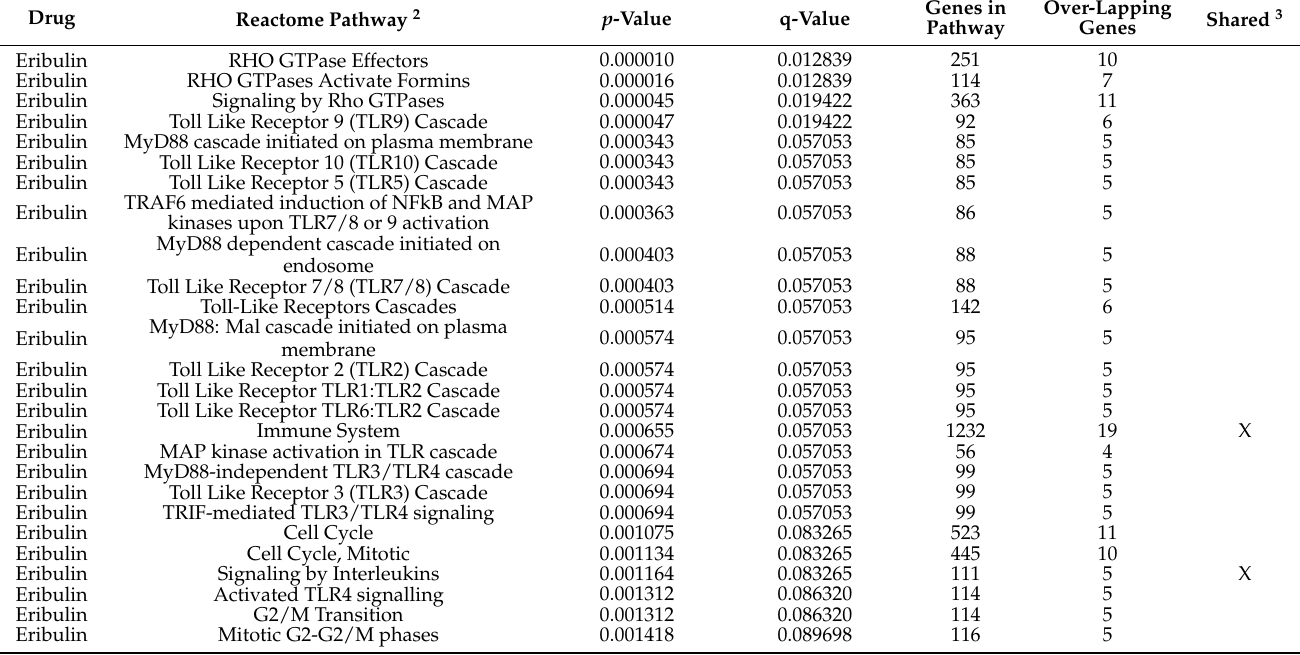
Figure 4. Network propagation and Reactome pathway analyses. ( A , B ) Network propagation from query sets consisting of the 9 eribulin UFGs ( A ) and the 13 vinorelbine UFGs ( B ) yielded the 100- gene networks shown, which included 7 of the 9 eribulin UFGs and all 13 of the vinorelbine UFGs; 2 eribulin UFGs, C5ORF38 and GPR157 , were not themselves captured in the network propagation. Purple-highlighted network nodes represent original UFG query input genes. ( C – J ) Reactome pathways derived from the 100-gene query sets obtained from network propagation. Full Reactome maps are shown for eribulin ( C ) and vinorelbine ( D ), with blow ups of the Signal Transduction ( E , F ), Immune System ( G , H ) and Cell Cycle ( I , J ) islands shown for eribulin ( E , G , I ) and vinorelbine ( F , H , J ). Table 3. Reactome pathways associated with eribulin and vinorelbine response at p < 0.05 plus q < 0.1 1